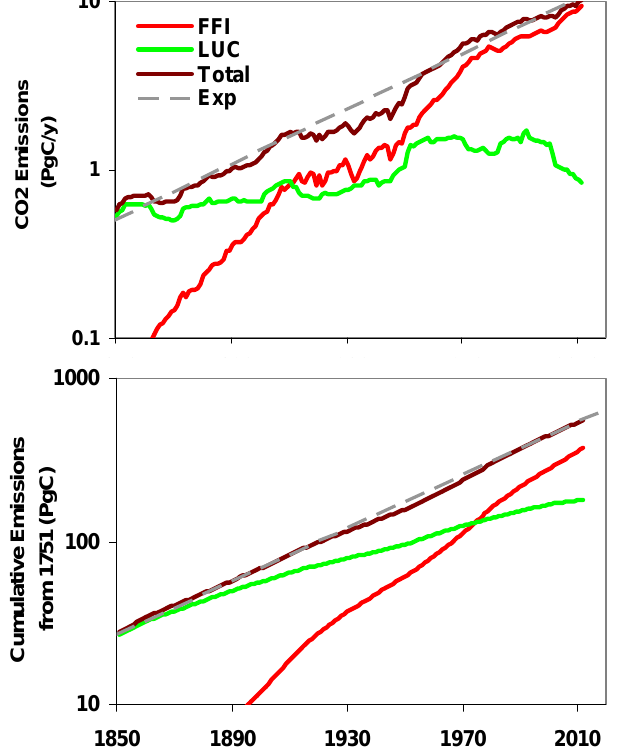
Fig. 1. Upper panel: observed total global CO 2 emissions, f E = f Foss + f LUC , as a function of time. Lower panel: cumulative global CO 2 emissions, Q E = Q Foss + Q LUC . The vertical axis in both panels is logarithmic so that exponentially growing emissions would appear as a straight line. The dashed line in both panels indi- cates exponential growth, proportional to e rt with r =1.89%yr − 1 . Data sources: Appendix C.